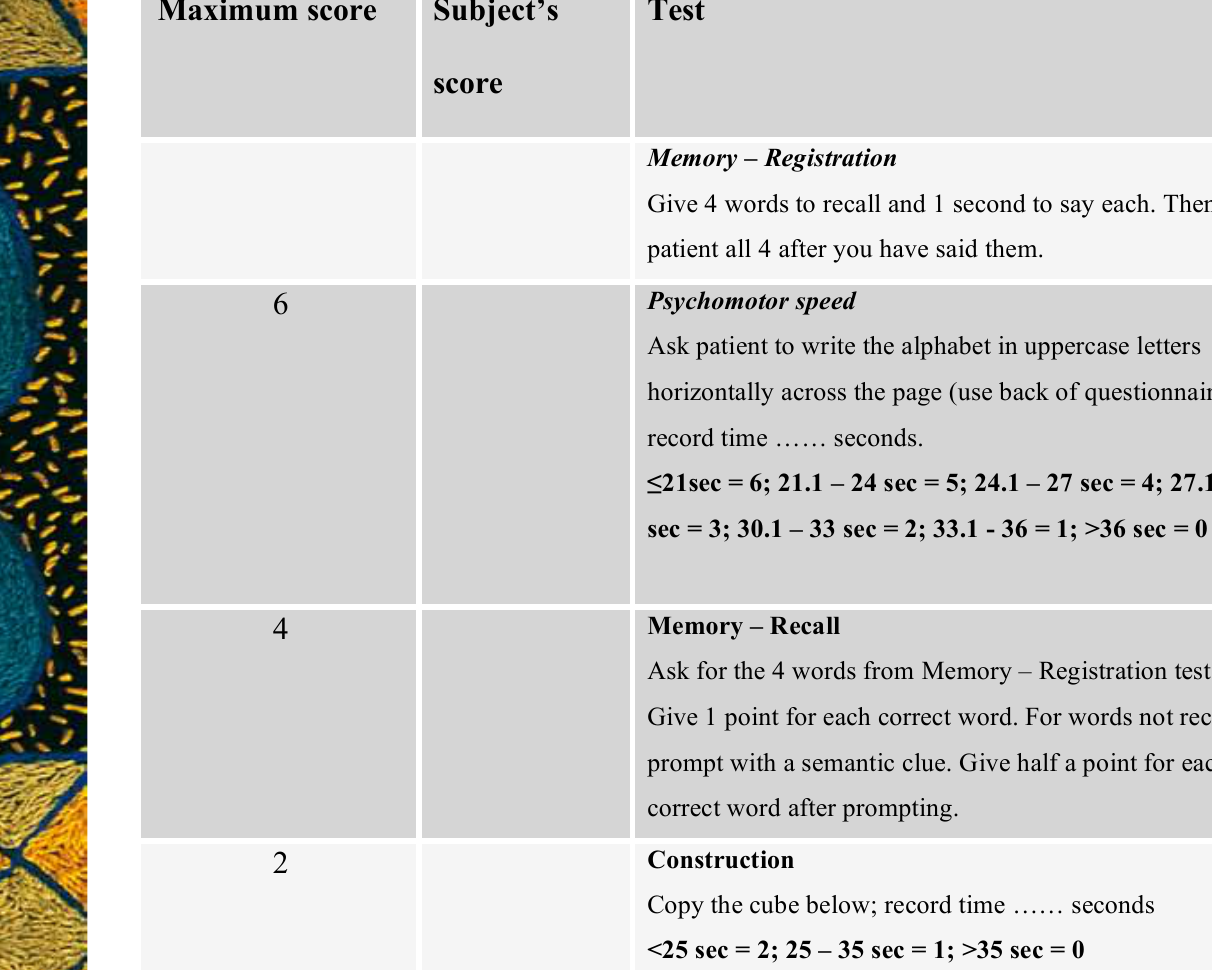
Fig. 1. Modified HIV Dementia